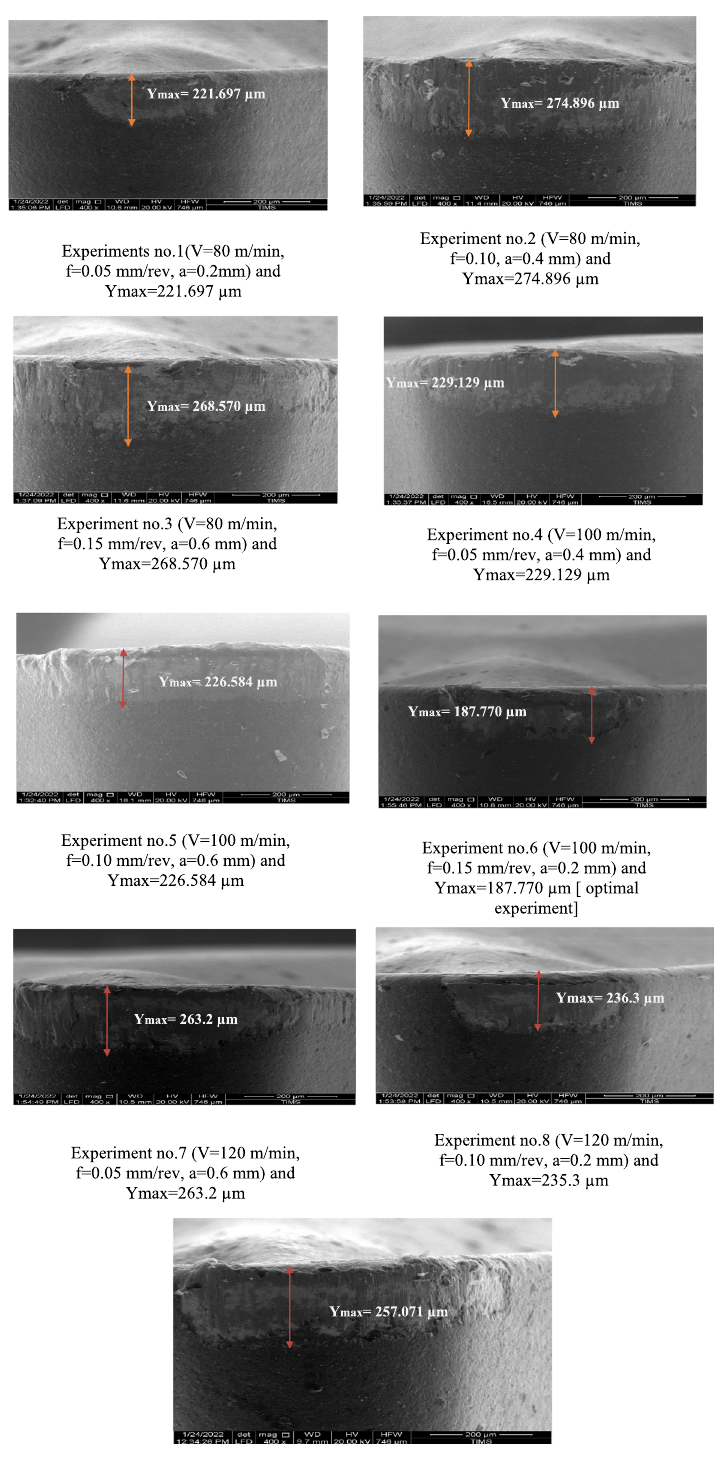
Fig. 6 SEM images of the flank